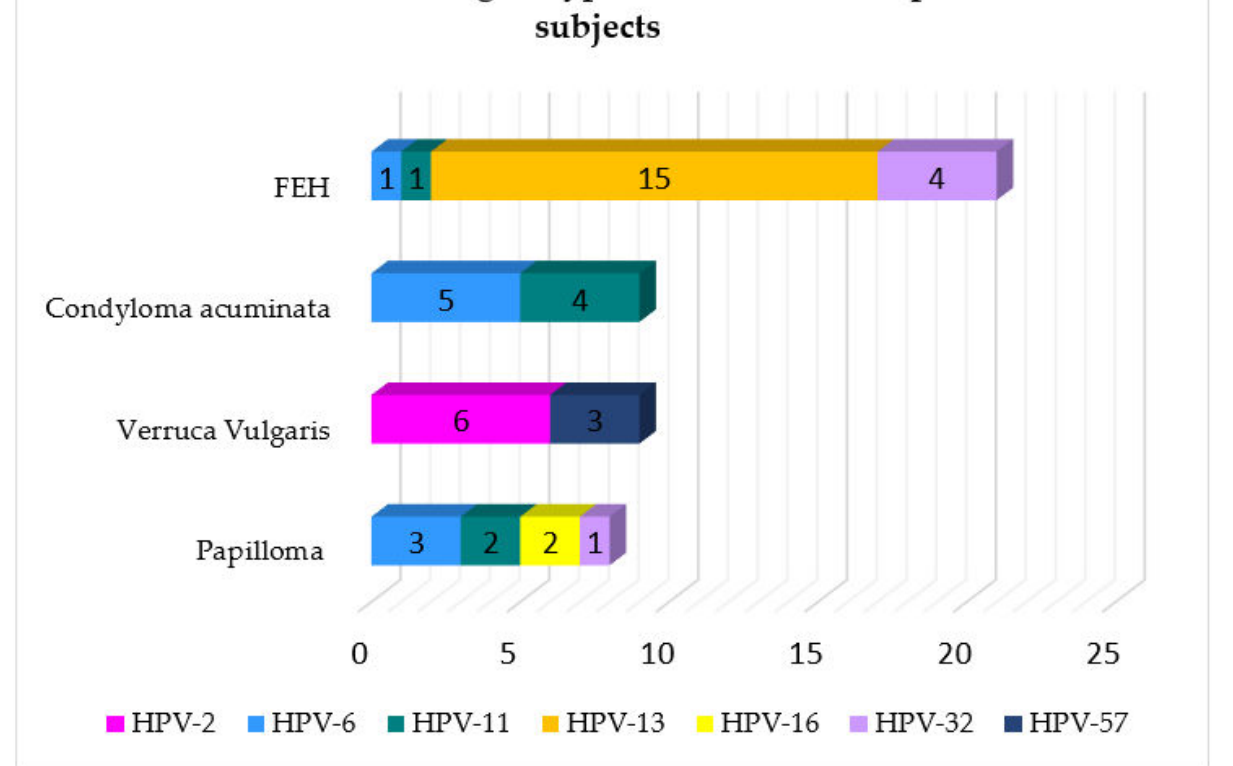
Figure 4. Distribution of HPV genotype in relation to the type of oral lesions reported in pediatric patients.